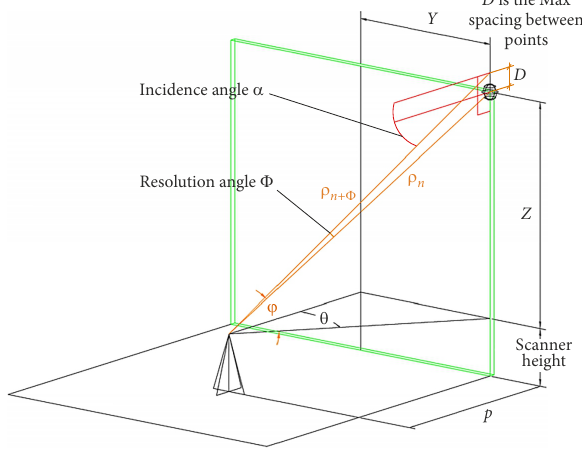
Figure 2. Scan position parameters